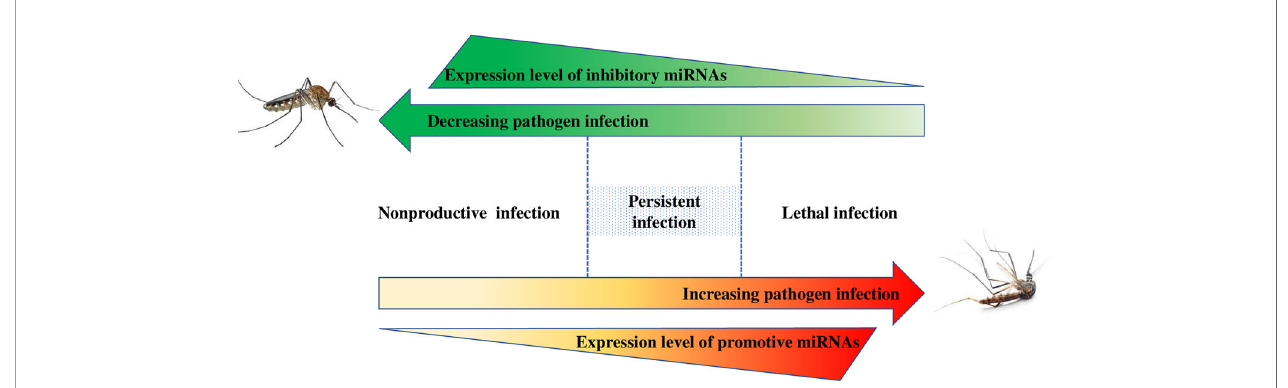
FIGURE 3 | Causal relationship between mosquito miRNAs and pathogen infection. The manipulation by miRNAs is mediated via a network. The inhibitory miRNAs and promotive miRNAs always coexist in mosquitoes, inhibiting or promoting pathogen infection, respectively. These miRNAs can balance the miRNA-pathogen interaction, maintain persistent infection and preventing considerable harm to